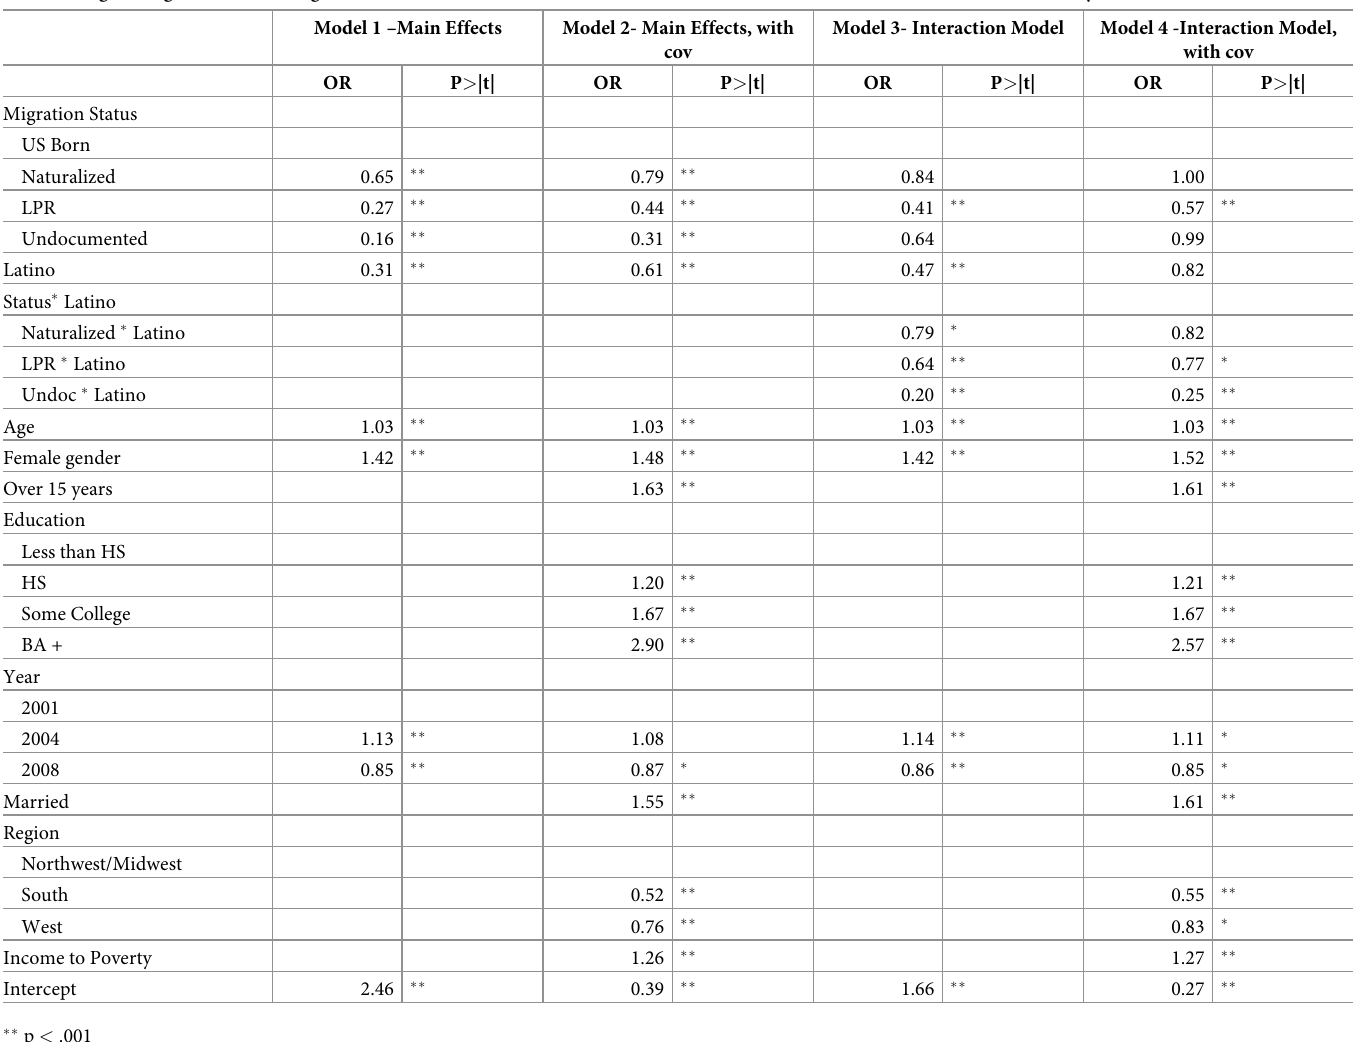
Table 4. Logistic regression for immigration status and current health insurance main effects and interaction between race/ethnicity, 2001/2004/2008